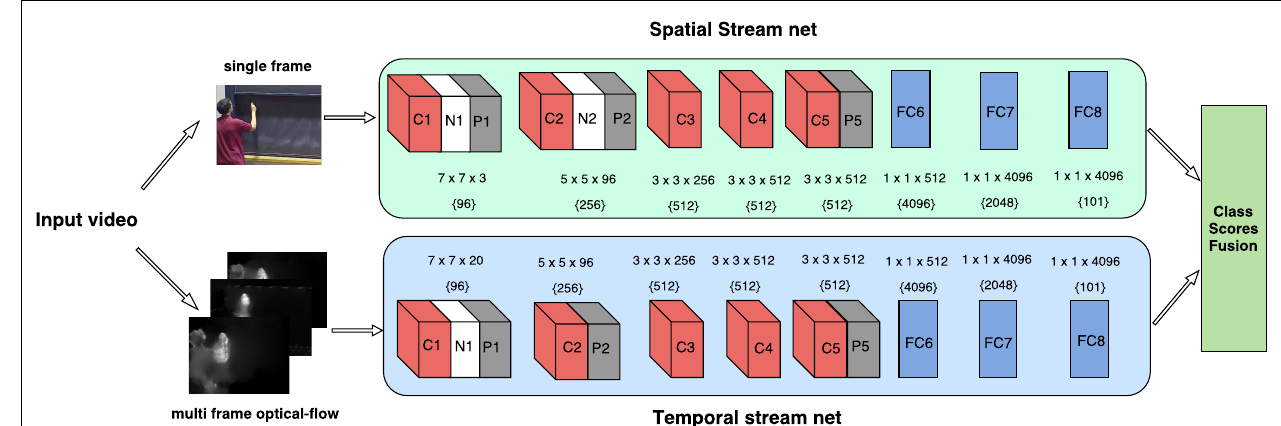
FIGURE 4 | Two-stream architecture for video classification from Simonyan and Zisserman (2014a) .